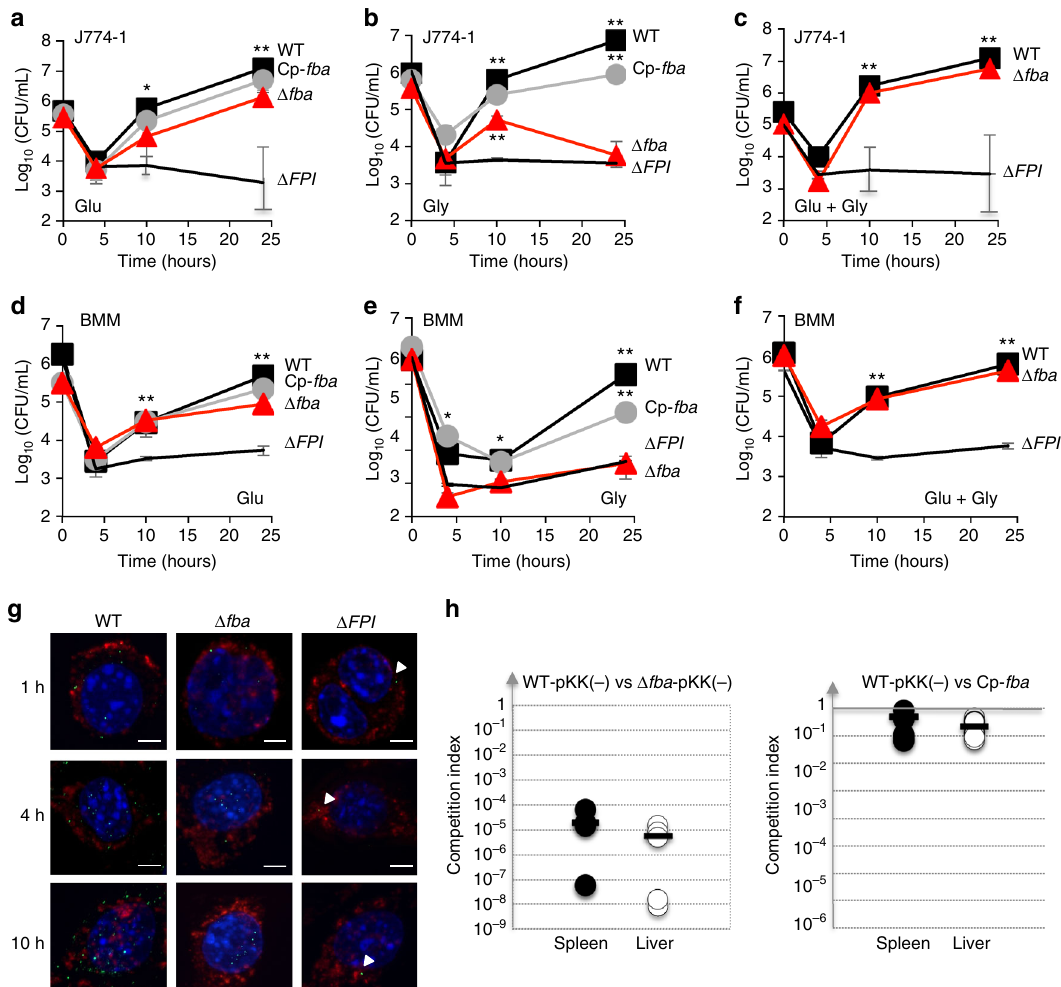
Fig. 3 fba inactivation affects intracellular survival. Intracellular bacterial multiplication of wild-type F. novicida (WT, black squares ), isogenic Δ fba mutant ( Δ FBA , red triangles ), and complemented Δ fba strain (Cp- fba , gray circles ), and the Δ FPI negative control ( black lines ), was monitored during 24 h in J774A.1 macrophage cells and bone marrow-derived macrophages (BMM) from 6 to 8-week-old female BALB/c mice. DMEM (Dulbecco ’ s modi fi ed eagle medium) was supplemented either with glucose a , d , glycerol b , e , or an equimolar concentration of glucose and glycerol c , f . a – f mean and SD of triplicate wells are shown. Each sugar was added to the cell culture medium at a fi nal concentration of 5 mM. * p < 0.01; ** p < 0.001 (determined by two-tailed unpaired Student ’ s t -test). g Glycerol-grown J774.1 were infected for 30 min with wild-type F. novicida (WT), Δ fba , or Δ FPI strains and their co-localization with the phagosomal marker LAMP-1 was observed by confocal microscopy 1, 4, and 10 h, after beginning of the experiment. Scale bars at the bottom right of each panel correspond to 5 μ M. J774.1 were stained for F. tularensis ( green ), LAMP-1 ( red ), and host DNA ( blue , DAPI stained). h Group of fi ve BALB/c mice were infected intraperitoneally with 100 CFU of wild-type F. novicida and 100 CFU of Δ fba mutant strain. Bacterial burden was realized in liver ( open circles , right column ) and spleen ( black circles , left column ) of mice. The data represent the competitive index (CI) value (in ordinate) for CFU of mutant/wild-type of each mouse, after 48 h infection, divided by CFU of mutant/wild-type in the inoculum. Bars represent the geometric mean CI